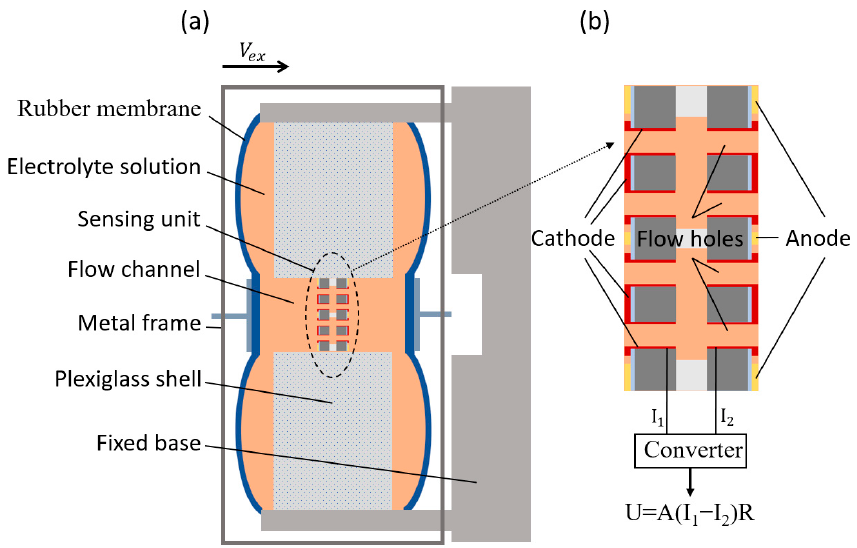
Figure 1. ( a ) Schematic diagram of the MEMS-based electrochemical seismometer developed in this study, consisting of: (1) two rubber membranes, (2) an electrolyte solution, (3) a sensing unit, (4) a flow channel, (5) a metal frame, (6) a plexiglass shell and (7) a fixed base. Two rubber membranes are sealed on the plexiglass block to form a sealed cavity, which is filled with the electrolyte solution, and the sensing unit is fixed in the middle of the flow channel. ( b ) Enlarged schematic diagram of the sensing unit with (8) two anodes, (9) two cathodes and (10) flow holes.